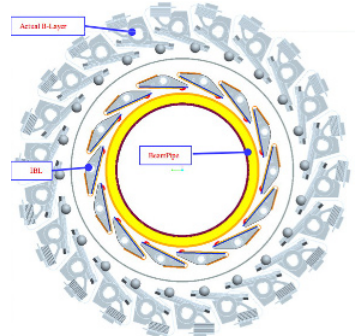
Fig. 2. Cross-section view of the current Pixel B-layer, the new beam pipe and the